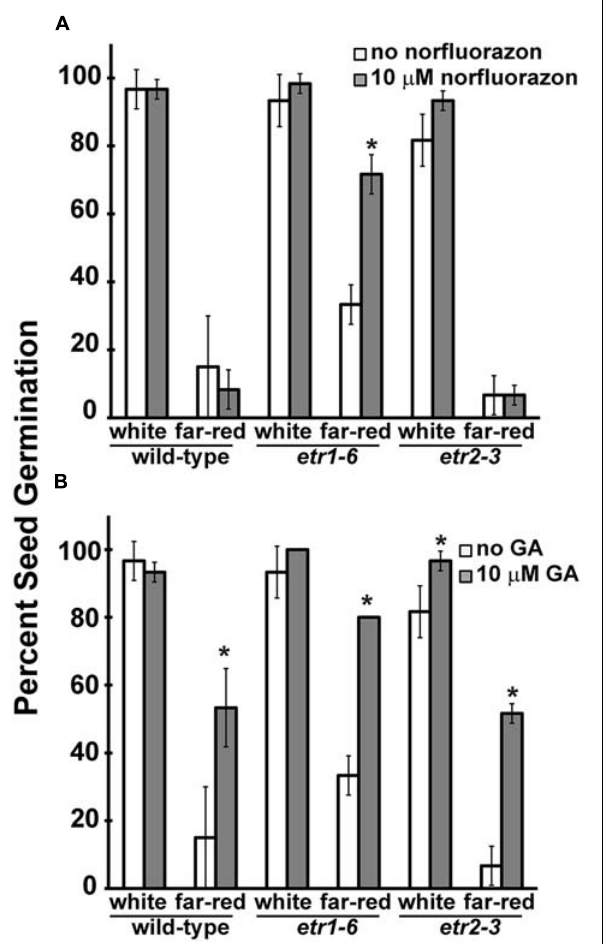
FIGURE 5 |The effects of gibberellic acid (GA) and norflurazon on seed germination after treatment with far-red light. Wild-type, etr1-6 , and etr2-3 seeds were germinated after treatment with white or far-red light. Seed germination was then measured 7 days later.The effects of (A) norflurazon and (B) GA were assessed. All experiments were performed in triplicate.The average percent seed germination ± SD is plotted. Data were analyzed by t -tests and differences considered statistically significant with P < 0.05. *Denotes that the compound had a significant effect compared to the non-treated control in that light